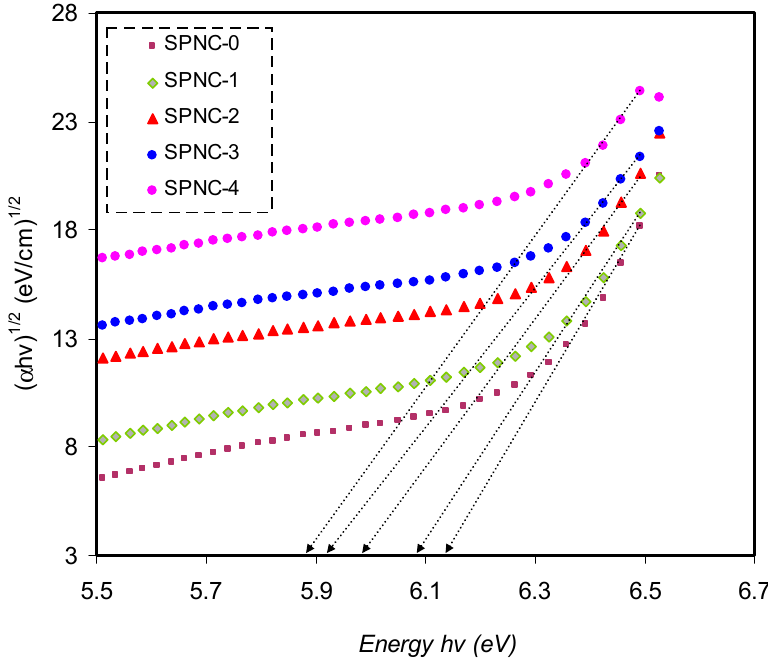
1/2 versus ( h υ ) for pure PVA and PVA-doped Figure 12. The plots of (𝛼ℎ𝜐) (cid:2869)/(cid:2870) versus ( h υ ) for pure PVA and PVA-doped samples. Figure 12. The plots of ( α h υ )